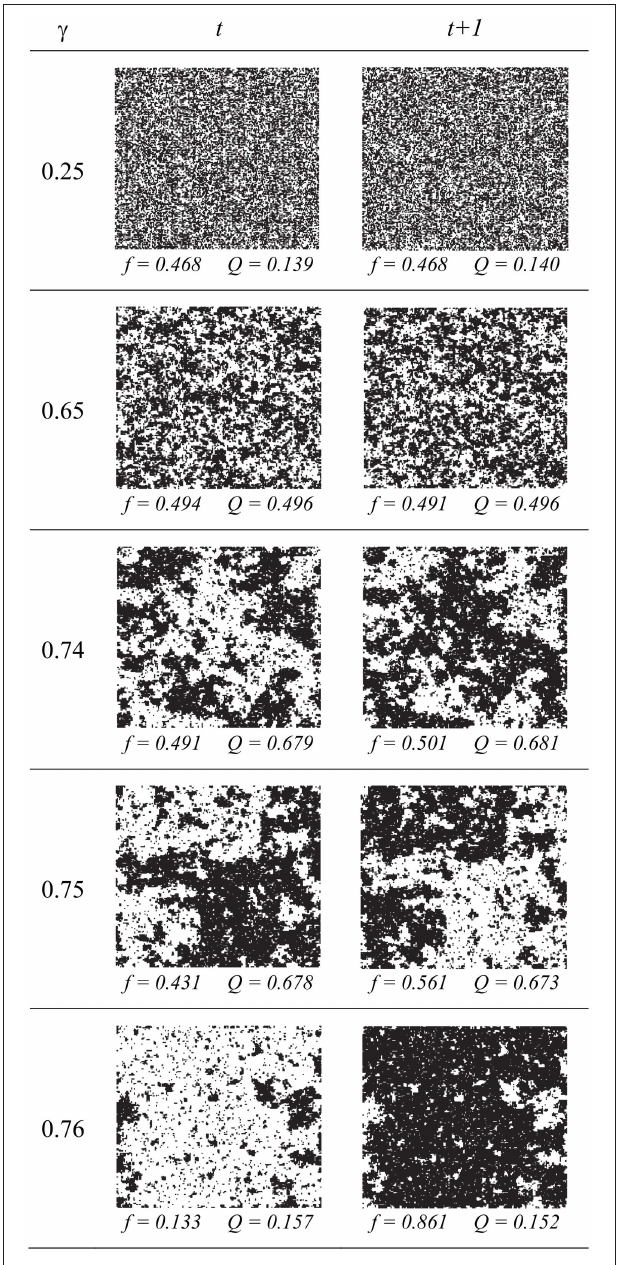
FIGURE 3 | Simulation results in the PCA after 500,000 update steps, for five different values of γ (recruitment probability). Black is active and white is inactive. The left and right panels in each row are two consecutive time steps. The active fraction f begins to alternate around γ = 0.75. Spatial clustering ( Q ) increases as γ increases, and is strongest immediately before the onset of alternation (periodicity). In all cases, α was fixed at